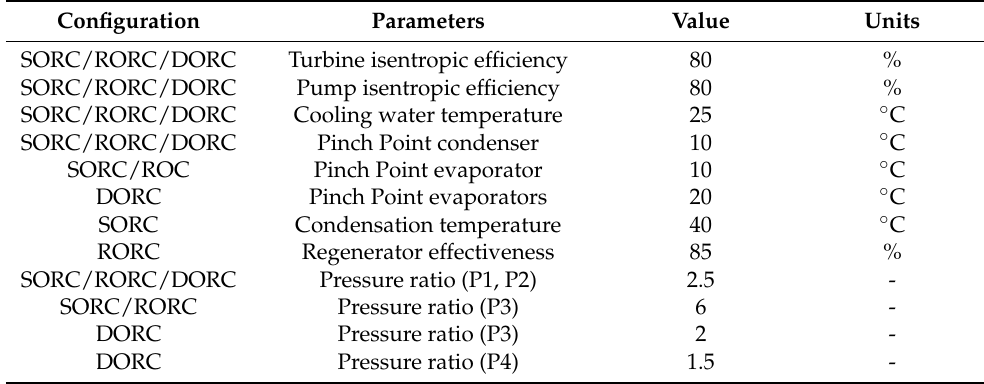
Table 3. Initial values for the modeling of the ORC configurations.